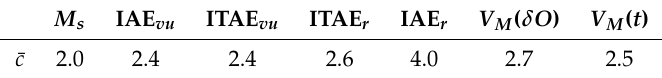
. Comparing the different s